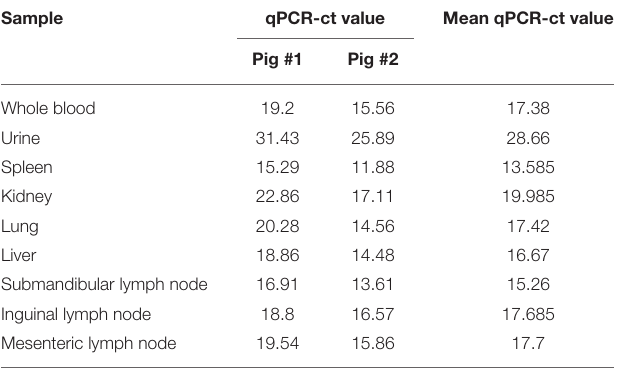
TABLE 1 | Distribution of ASFV by qPCR (19) in different body fluids, organs, and tissues from the first 2 infected pigs detected in Vietnam,